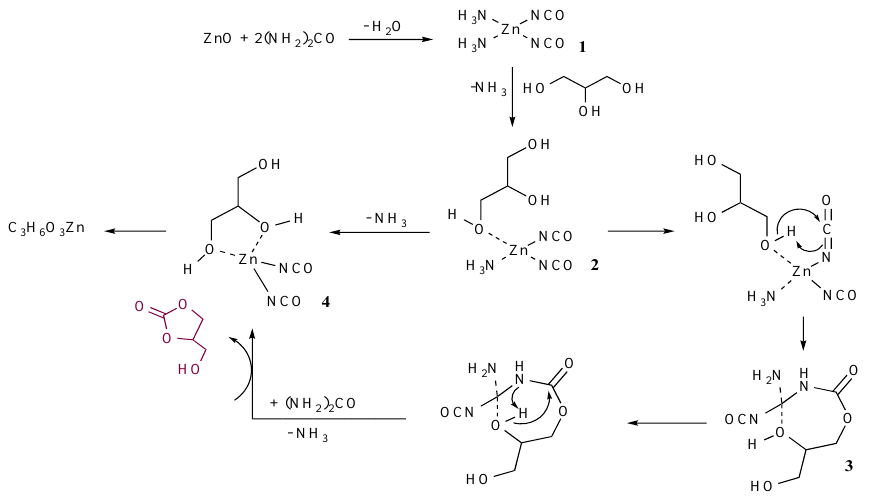
Scheme 2. Mechanism of reaction of glycerol with urea catalyzed by